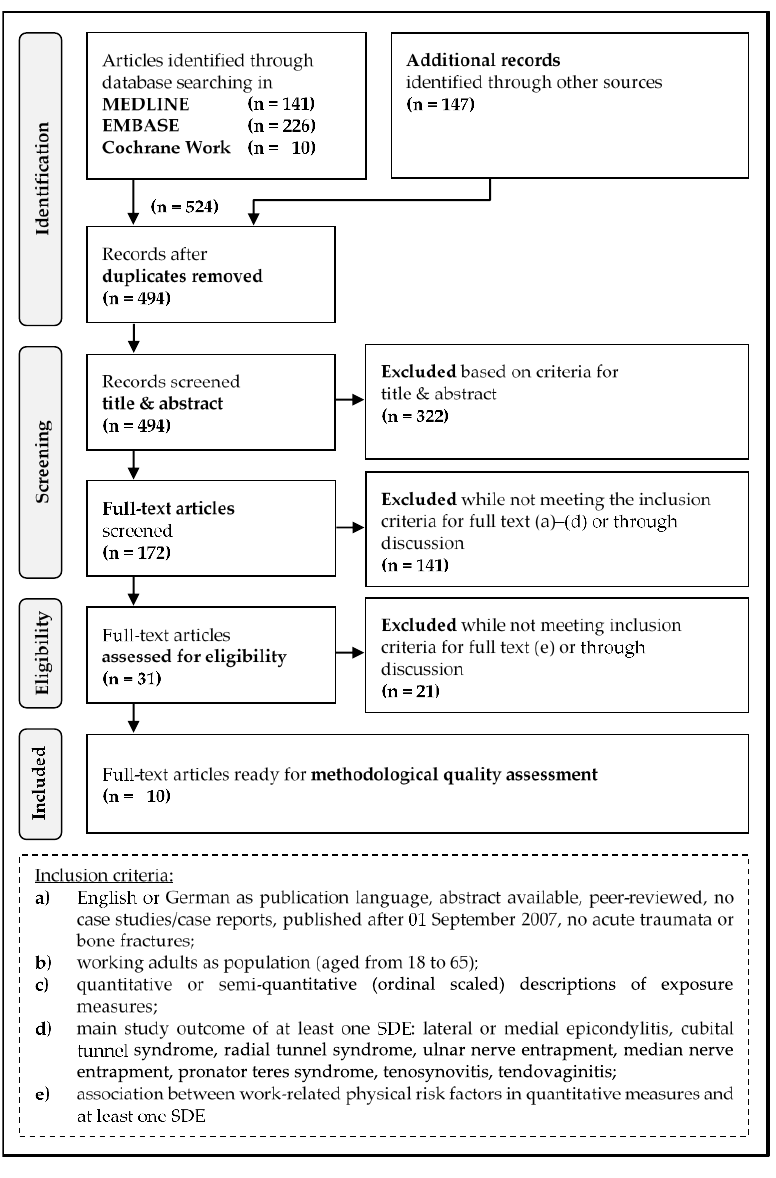
Figure 1. PRISMA Flow Diagram: This figure shows the study selection process of articles including physical risk factors associated with specific disorders at the elbow.